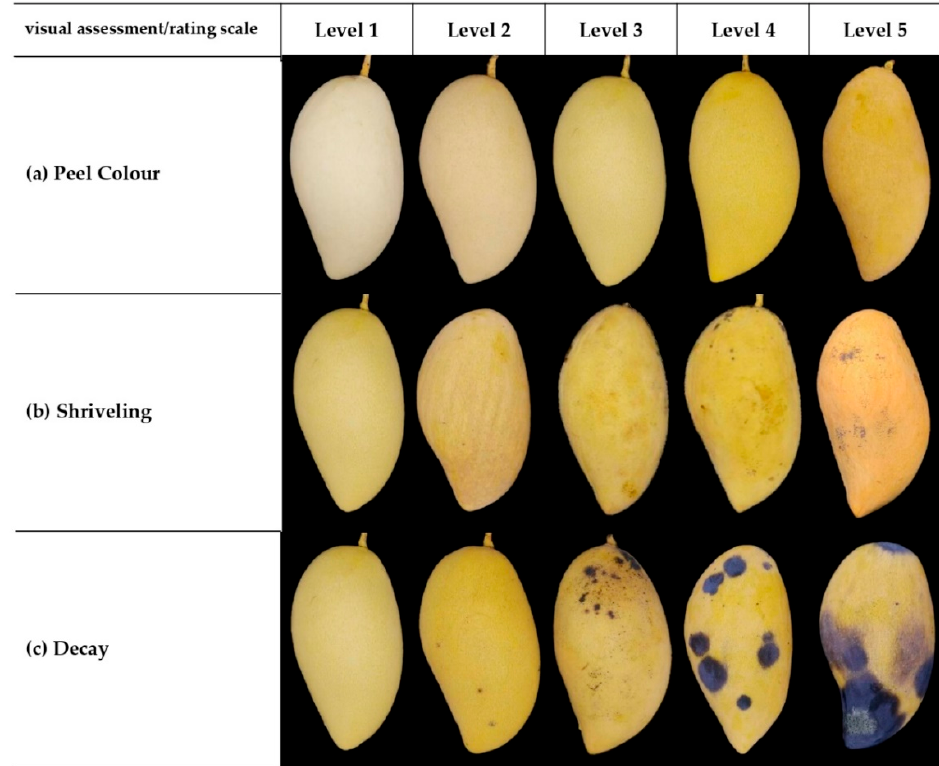
Figure 2. ( a ) Peel colour rating scale, ( b ) shrivelling rating scale, and ( c ) decay rating scale of ‘Nam Dok Mai Si thong’ mango fruits. Dok Mai Si thong’ mango